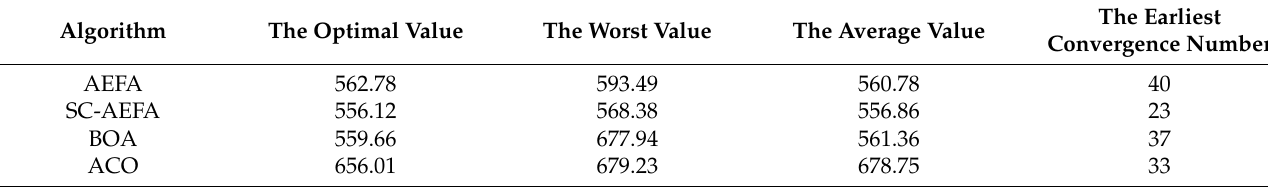
Table 7. The comparison of